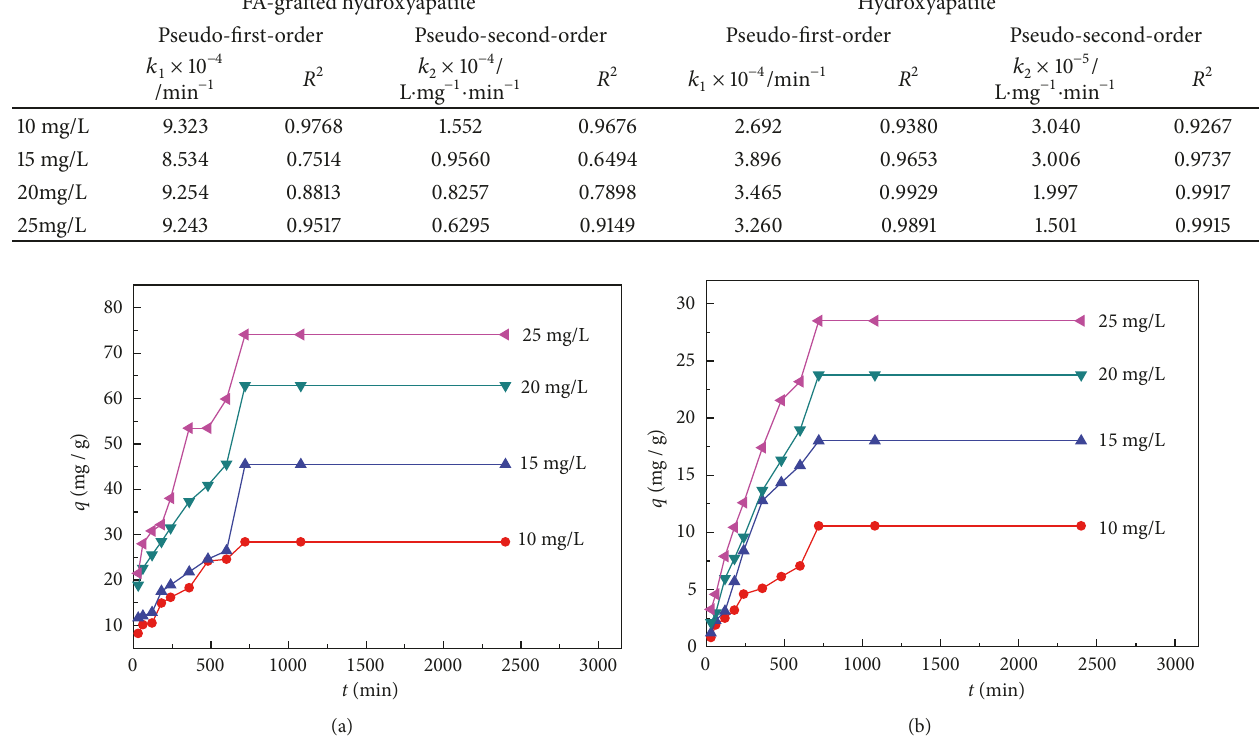
Figure 6: Adsorption capacity of the samples at the various drug concentrations as a function of time. (a) FA-grafted hydroxyapatite; (b)